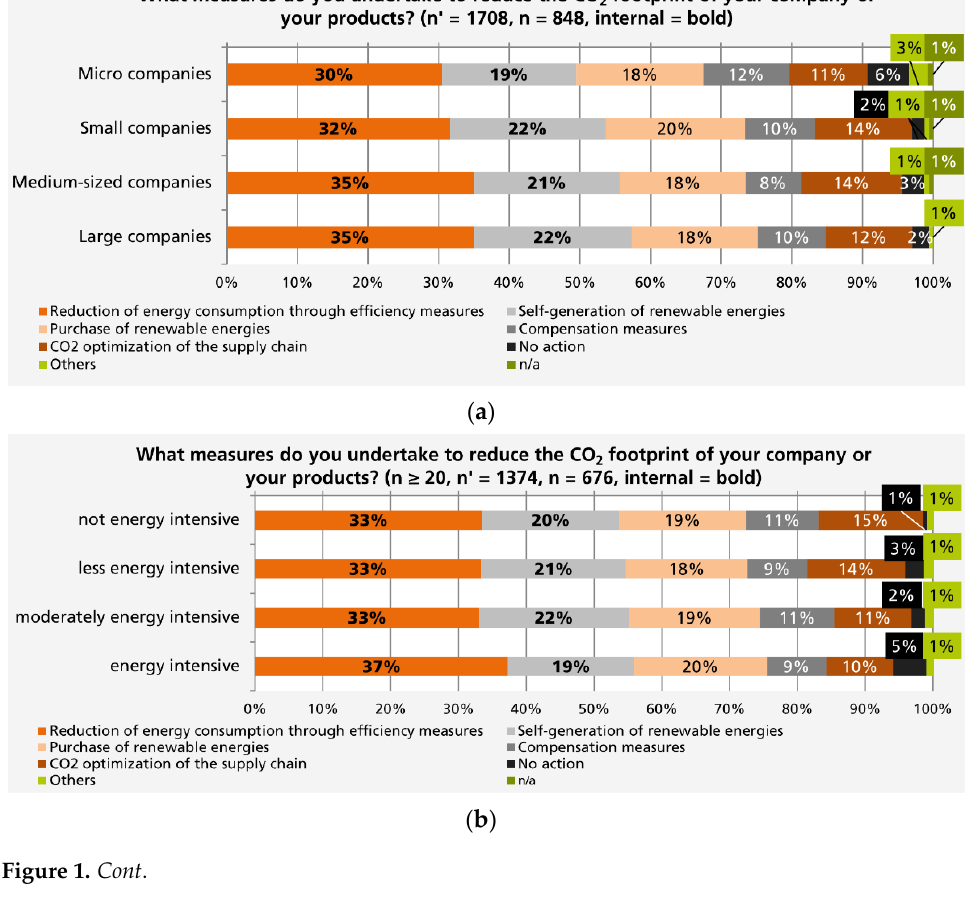
( c ) Figure 1. ( a ) Measures undertaken to reduce the CO 2 footprint of a company or products, by com- pany size; ( b ) measures undertaken to reduce the CO 2 footprint of company or products, by energy